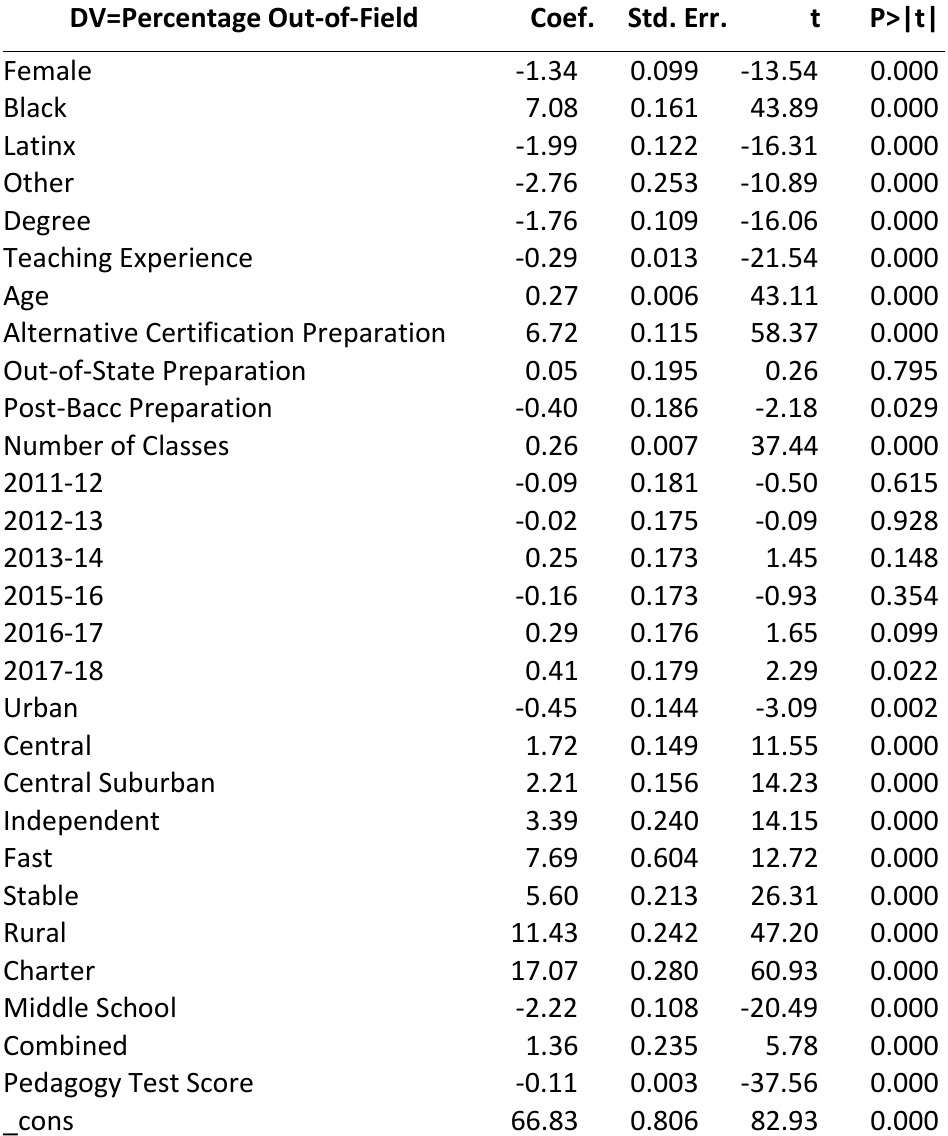
Table 2: Regression Results for Percentage of Classes Taught Out-of-Field by Teacher and Campus